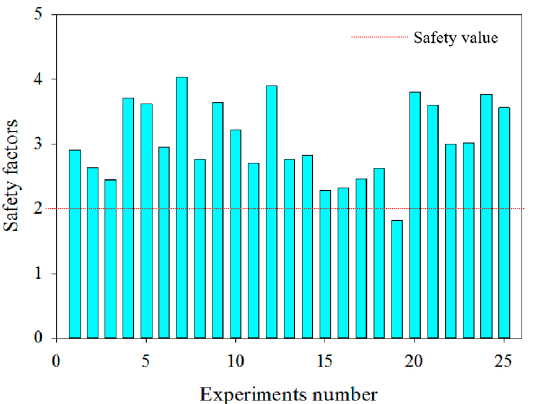
Figure 9. Safety factors of the underground backfill pillars obtained by numerical simulation. Table 6. The ANOVA of the safety factor of the underground backfill pillars obtained by the numerical simulation. Source of Variance Sum of Square Degree of Freedom Mean Square Value of F 1 Foundation strength (A) (MPa)